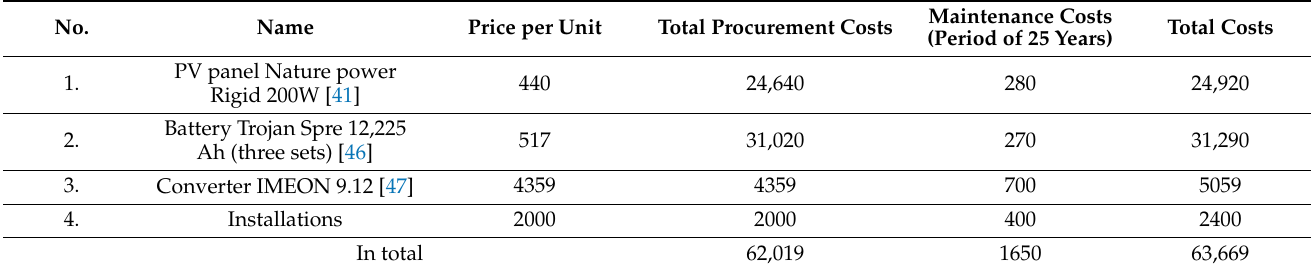
Table 3. Costs of all solar system elements are shown in €